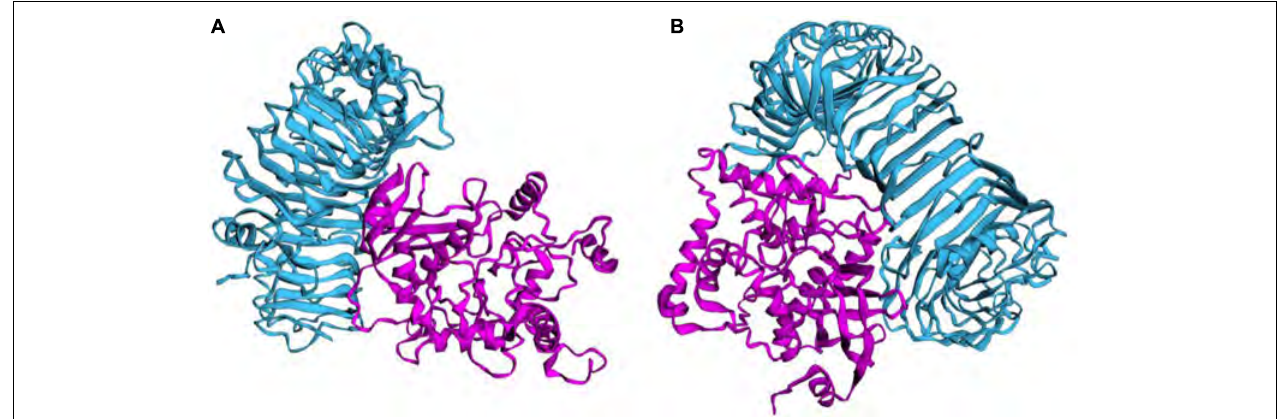
FIGURE 6 | Ligand–receptor interaction. C543P was shown in purple and TLR2 (A) and TLR4 (B) were shown in blue.